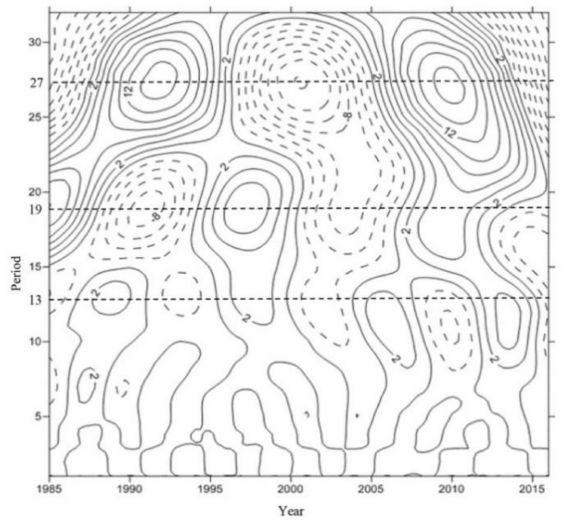
Figure 3. The wavelet analysis